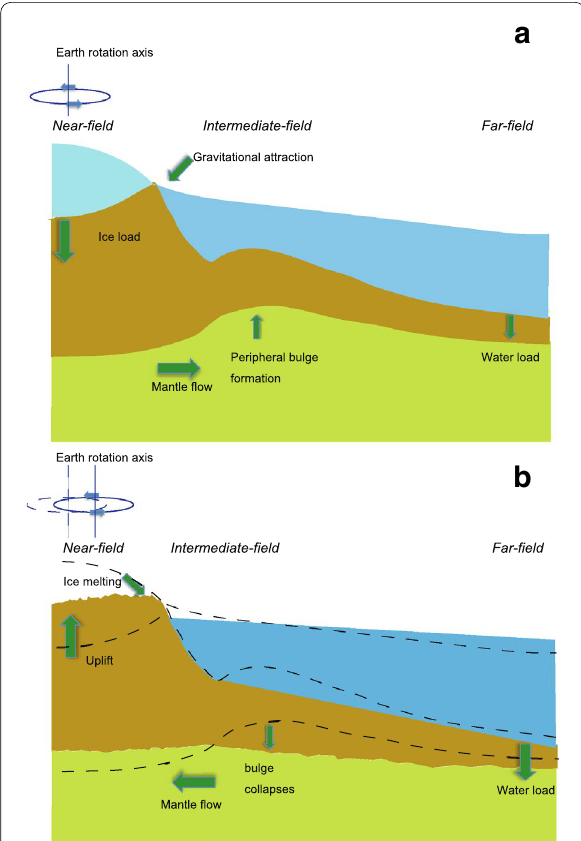
Fig. 6 Figure showing schematics of various geophysical processes related to sea-level changes. a Crustal loading underneath of ice sheets in the “near-field” or center of ice sheet increases and mantle material flows beyond the ice sheet to form a peripheral bulge in the “intermediate-field” during ice sheet advances. Sites far from the ice sheet regions, where direct loading effects due to the change in ice sheet geometry is negligible are called “far-field”. For these locations, changes in the geometry and magnitude of water load influence the change in RSL. b The opposite is true during the waning phase of global ice sheets. Crustal uplift and peripheral bulge collapse occur in the near- and intermediate-fields due to mantle flow. In the far-field, a sea-level high-stand results from ocean siphoning due to the combination of bulge collapse and mantle flow from beneath the newly-loaded ocean basins. Earth’s rotational axis shifts because of mass exchanges between ice sheets and oceans and the effect of this process on Earth’s moment of inertia which in turn alters the centrifugal force applied to the water within the ocean basins. Reduction or increase in ice sheet mass produces a corresponding fall or rise in near-field sea level due to the change in gravitational attraction of the ice sheet on the water in the ocean